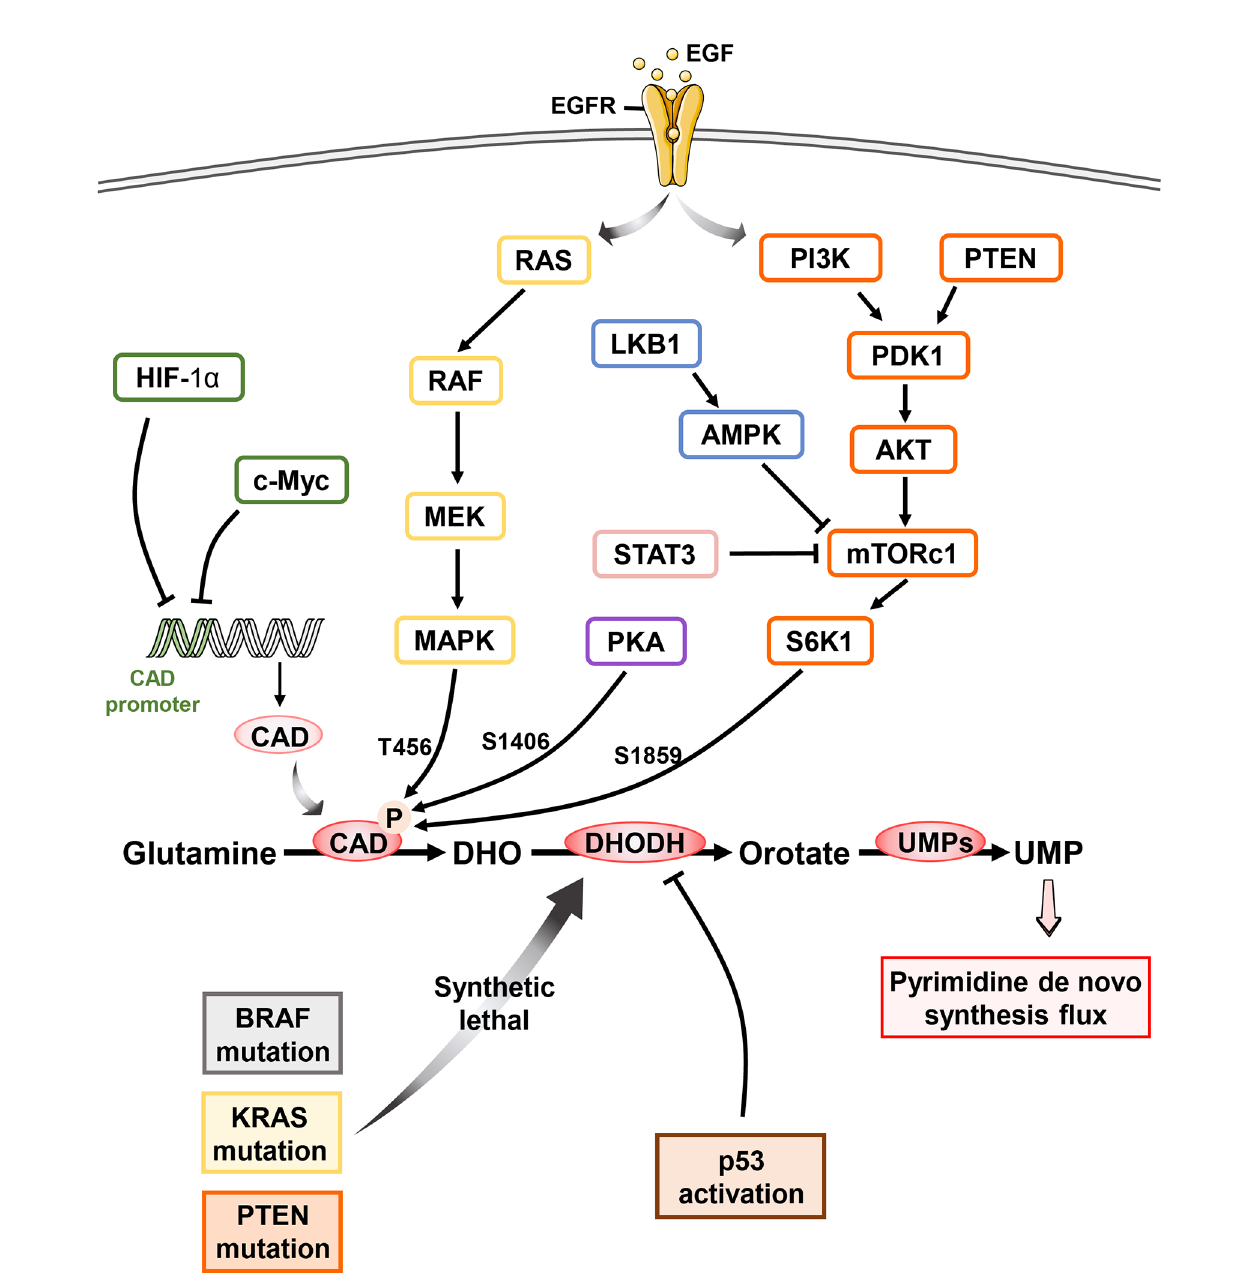
FIGURE 3 | Oncogene reprogram pyrimidine metabolism in cancer Pyrimidine metabolism in cell is regulated by multiple oncogenes and suppressors. Upon the activation of epidermal growth factor, c-Myc dictates the CAD transcription by binding the CAD promoter while HIF-1 a exhibits the same pharmacological effect without the participation of EGF. RAS-RAF-MEK-MAPK signaling pathway mediates the phosphorylation of CAD at T456 while PKA phosphorylates S1406 of CAD. Besides, mTOC1 activation following the PI3K/Akt signaling results in the S6K1-regulated phosphorylation of CAD at S1859, which is also inhibited by LKB1 and STAT3 pathways. Both modi fi cations of CAD stimulate the pyrimidine de novo pathway fl ux and promote the pyrimidine synthesis. Cancer cells with BRAF, KRAS as well as PTEN mutation dependent more on pyrimidine de novo pathway and exhibit synthetic lethal vulnerability upon DHODH inhibitor. Most importantly, p53 activation is potentially related to the dysfunction of